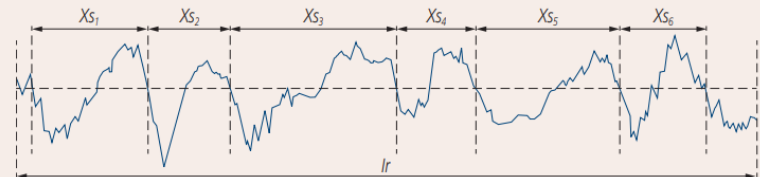
Figure 16. The mean groove spacing RSm as the mean value of the spacing Xsi of the profile elements. The value of the Ra roughness average parameter was determined separately for the outer layer and middle layer of the MDF. Therefore, the additional effect of both the density and hardness of the workpiece on the Ra parameter can be